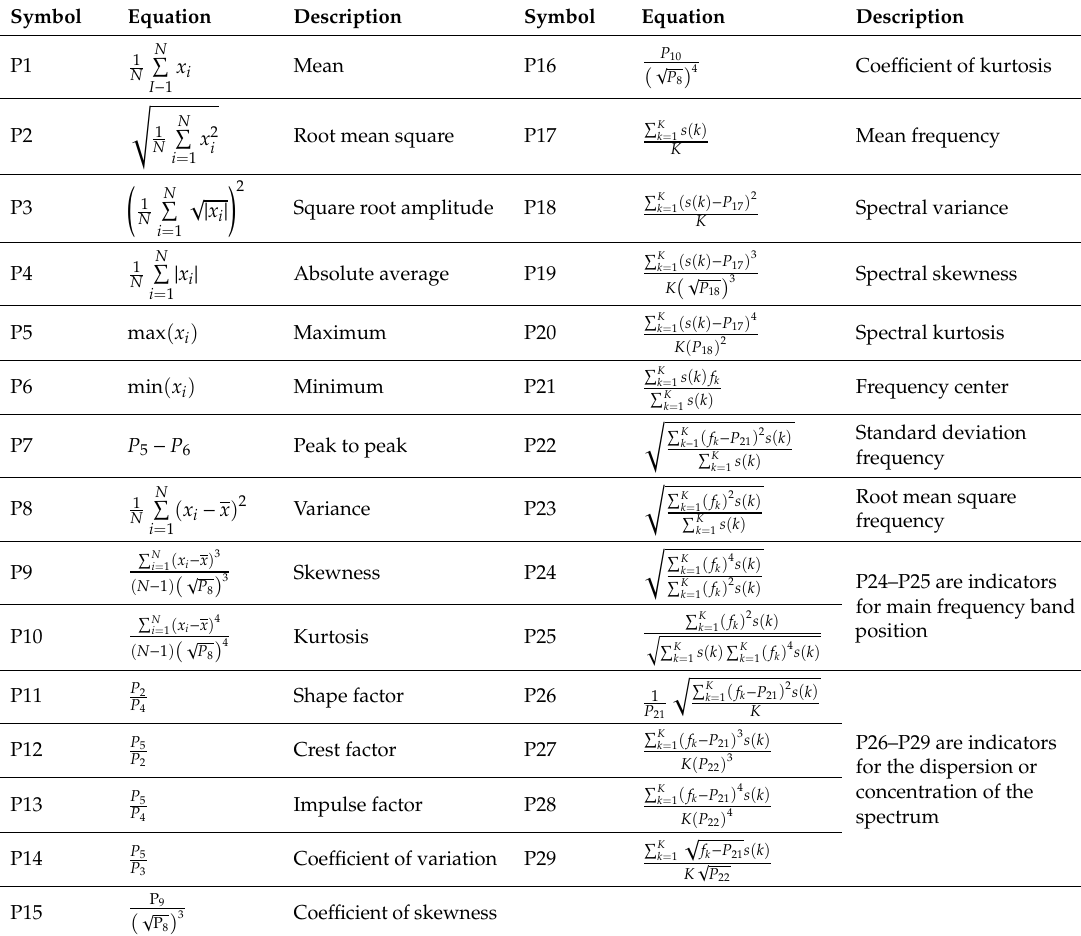
Table 1. List of